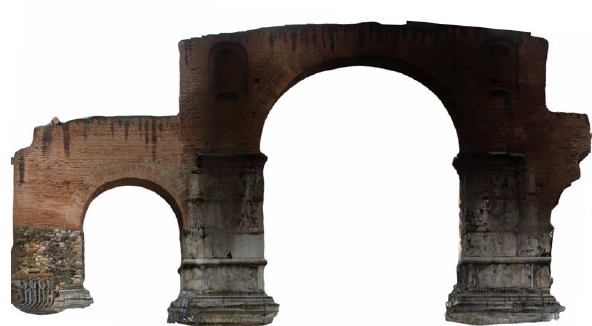
Figure 9. Orthoimage of the east facade